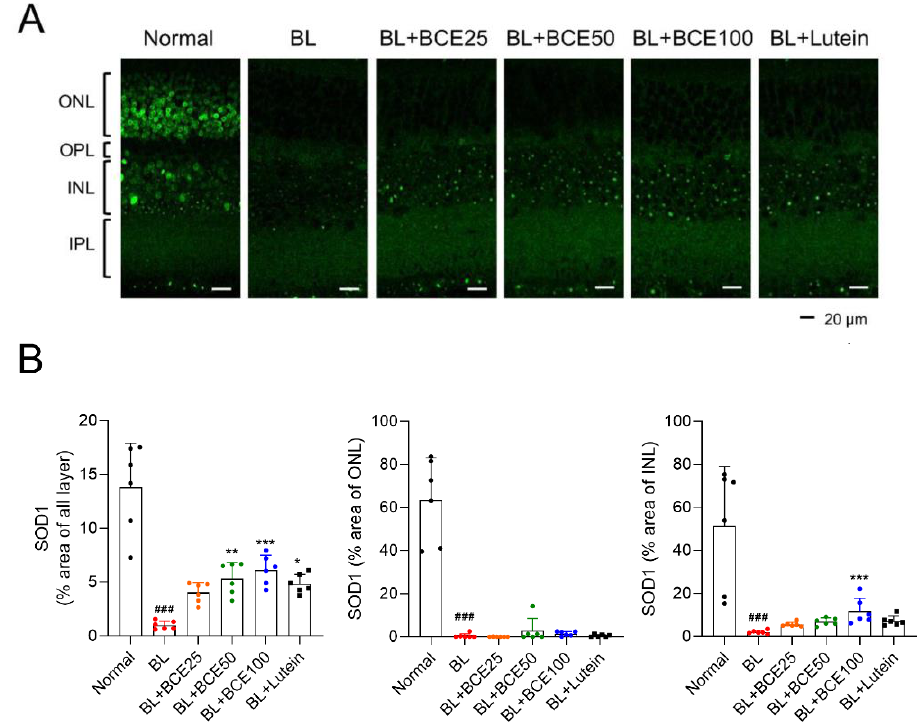
Figure 5. Effects of BCE on SOD1 expression in the BL-induced retinal degeneration mouse model. ( A ) Immunofluorescence staining to analyze SOD1 expression in all layers of the retina. Sections between 100 and 200 µ m from the optic nerve of both eyes were observed. ( B ) The SOD1 protein levels were quantified using Image J. INL, inner nuclear layer; IPL, inner plexiform layer; ONL, outer nuclear layer; OPL, outer plexiform layer. The results are presented as the mean ± standard deviation. ( n = 6). ### p < 0.001 vs. normal group. * p < 0.05, ** p < 0.01, *** p < 0.001 vs. BL group.